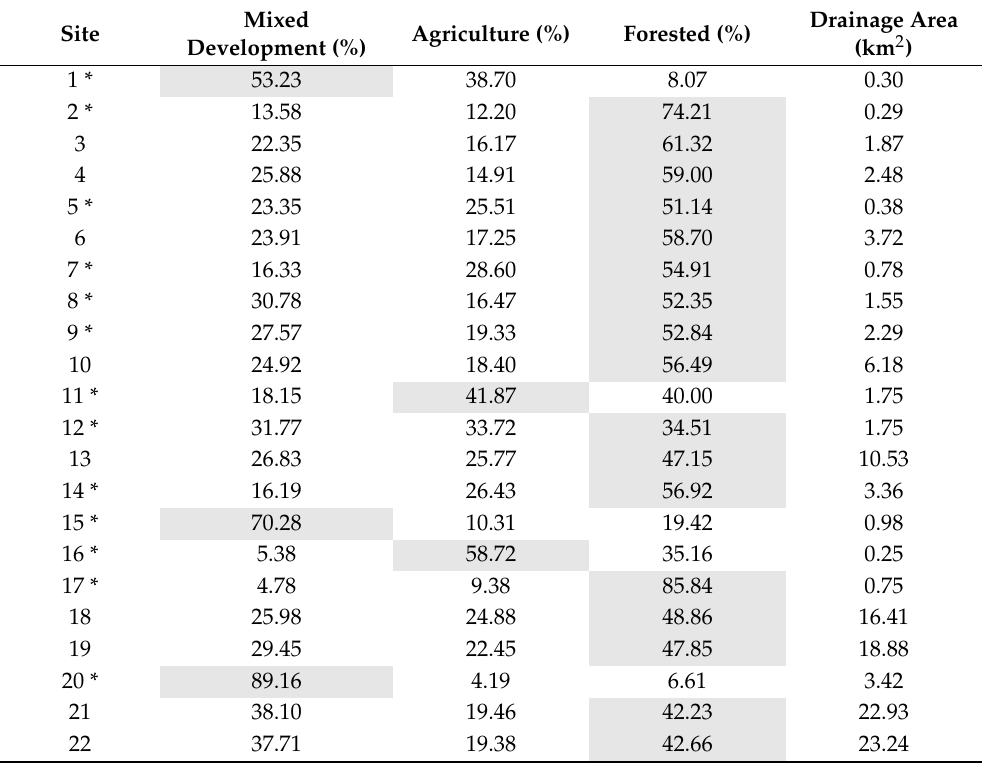
Table 1. Land use/land cover characteristics (% cover) and total drainage area (km 2 ) of 22 monitoring sites (and associated sub-catchments) in West Run Watershed (WRW), West Virginia, USA. Land use percentages may not sum to 100%, as not every category is included (e.g., wetland, open water). Some categories are combinations of others (e.g., mixed development = urban + residential). Final row (Site #22) indicates the total values for the entire watershed. Shading denotes dominant land use practice by